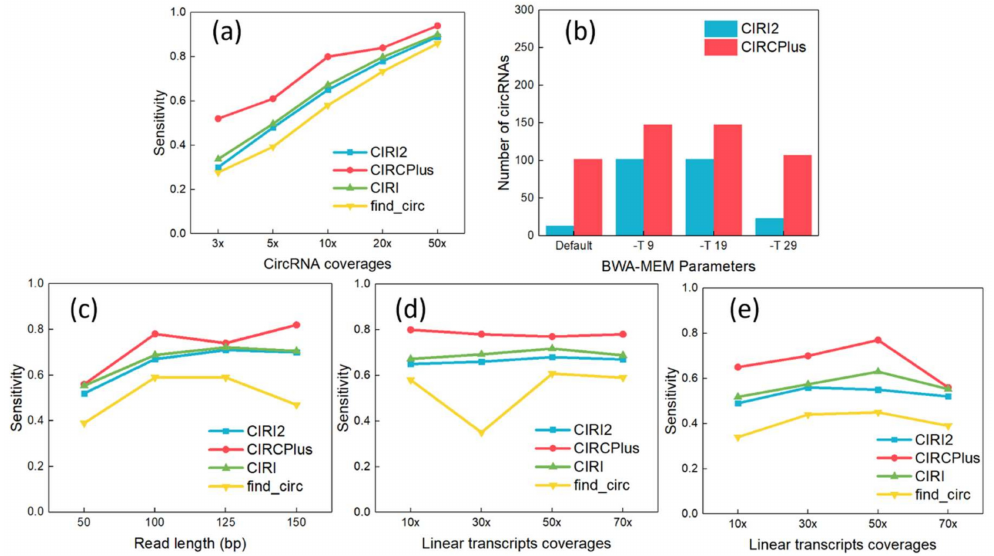
Figure 1. ( a ) Sensitivity analyses under different read depths of circRNAs (The read length was fixed to 100 bp). ( b ) Different parameter configurations of BWA–MEM affected the performance of detection on true positives (TP). ( c ) Sensitivity analyses under different read lengths. ( d ) Sensitivity analyses under different read depths of linear transcripts (The read length was fixed to 100 bp). ( e ) Sensitivity Analyses under different read depths of linear transcripts (The read length was fixed to 50